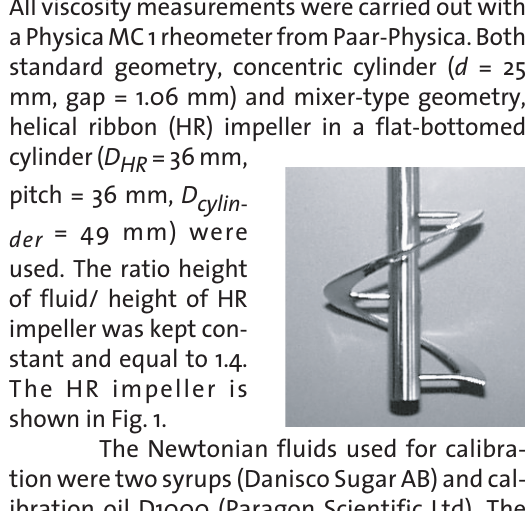
Figure 1: The used helical ribbon